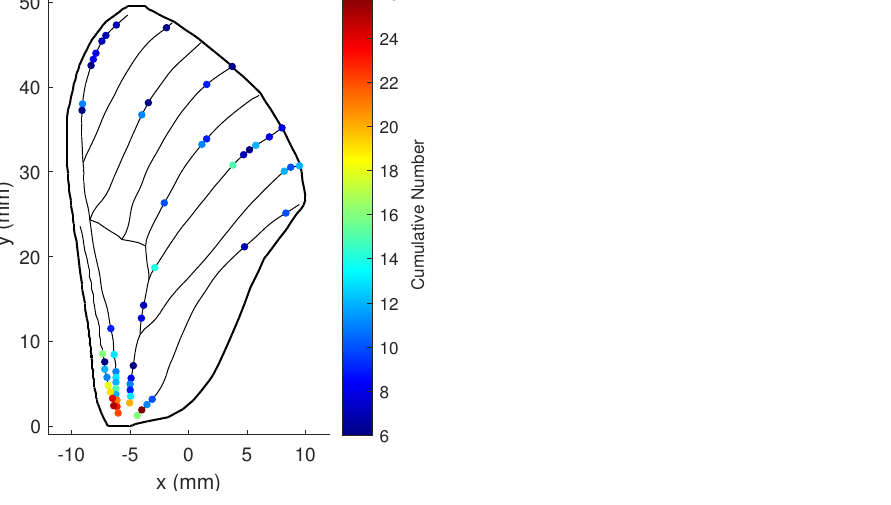
Figure 21. Cumulative numbers for being the optimal location when process and measurement noise variance is large: ω (cid:118) = 5, ω Υ = 100, and r =